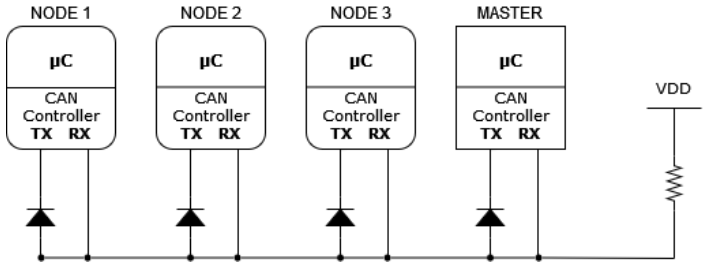
Figure 1. Principle diagram of the test bench. The master triggers three slave nodes, which synchro- nize themselves following the technique proposed in this paper. The CAN line is configured for wired and operation.